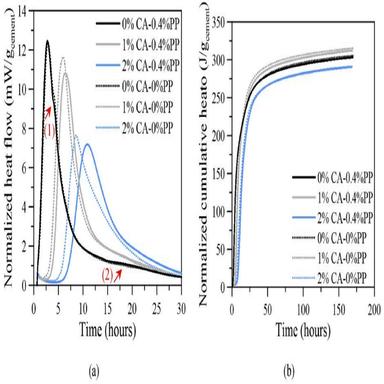
Isothermal calorimetric curves of samples with and without PP at different CA dosages (0%, 1%, and 2% bwoc): (a) Heat flows and (b) cumulative heats.